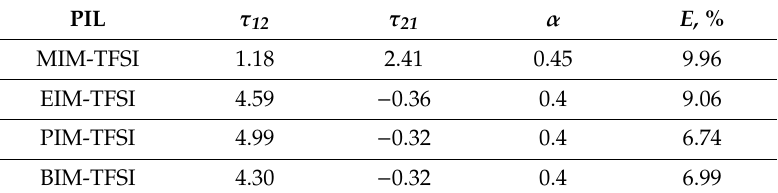
Table 3. Binary interaction parameters and mean relative deviation modulus E of experimental phase equilibrium with the NRTL equation for the binary system (water (1)-PIL (2)). PIL